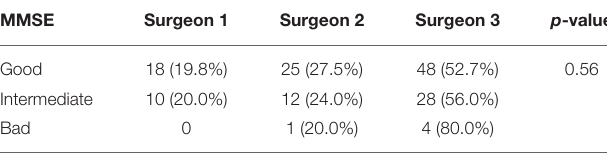
TABLE 3 | Difference between surgeon groups and MMSE distribution.